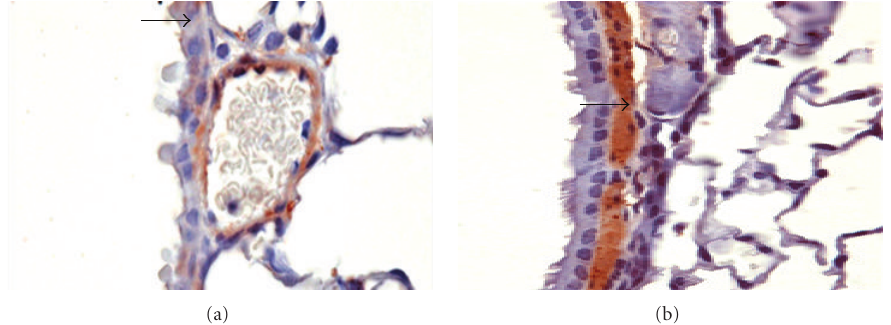
Figure 11: Mouse bronchioles. (a) Normal bronchioles label with alpha-actin (arrows). (b) Thickening smooth muscle layer after 12-week exposure to vanadium. Original magnification 100x.